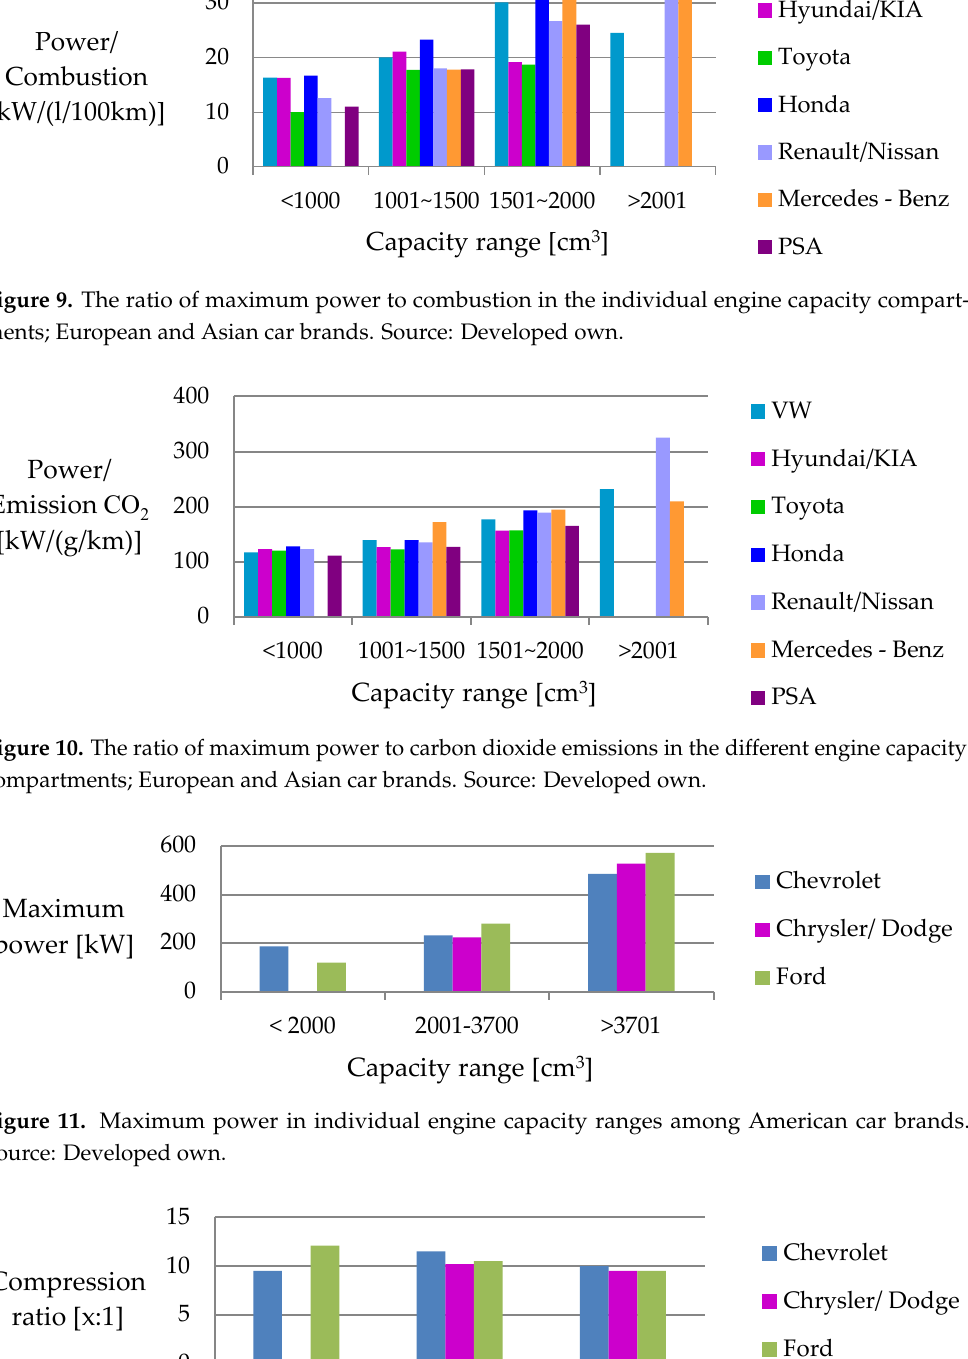
Asian car brands. Source: Developed own.